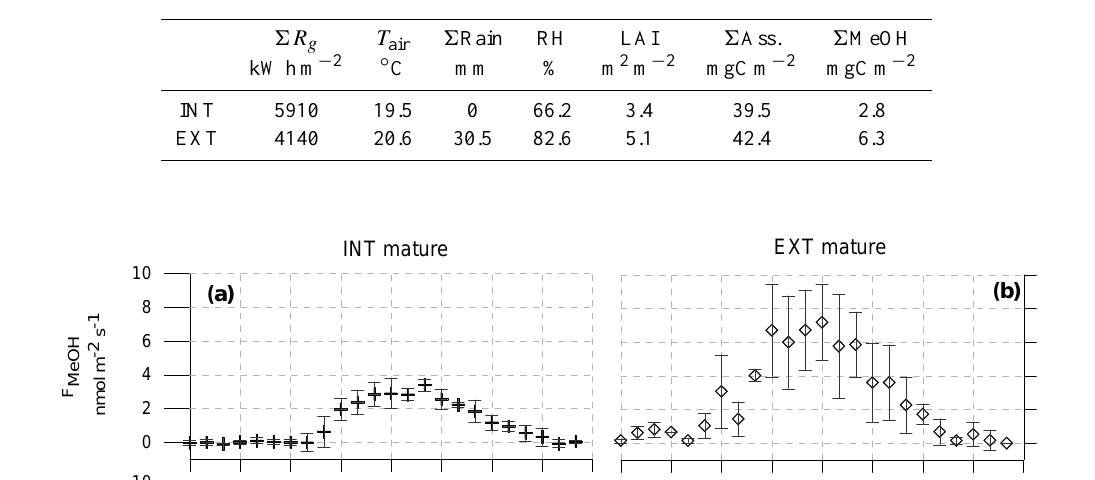
Table 2. Characteristics for the intensive and the extensive field during mature phase: 6-day mean of sum ( 6) of global radiation ( 6R g ) , air temperature ( T air : 24h mean), rainfall ( 6 Rain), relative humidity (RH: 24h mean), leaf area index (LAI), accumulated daytime (10:00– 16:00) carbon assimilation ( 6 Ass.), and the accumulated methanol emissions ( 6 MeOH).